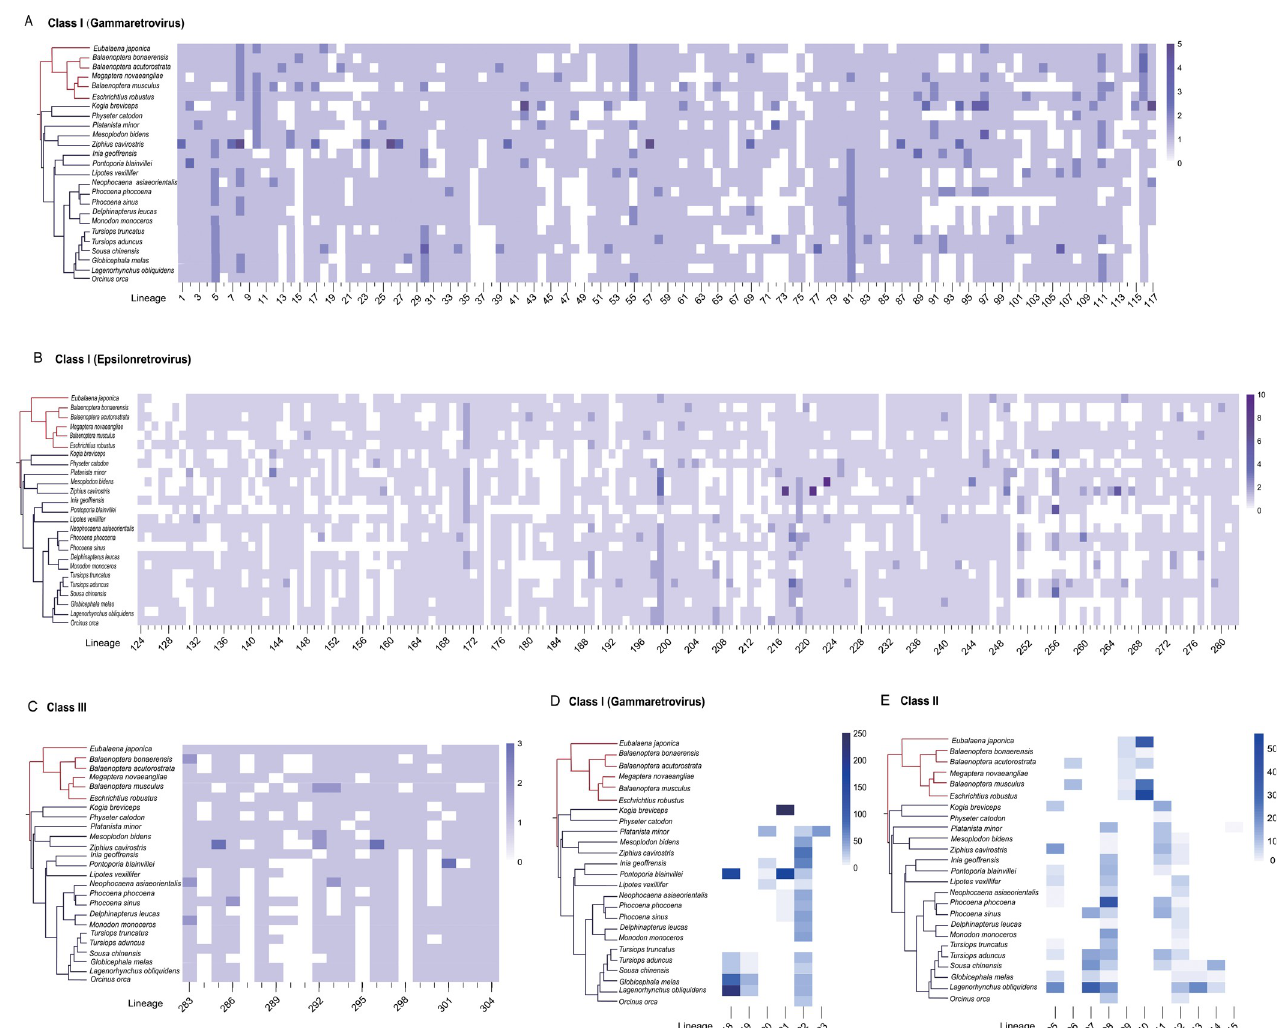
Fig 2. The copy numbers of distinct cetacean ERV lineages. ( A ), ( B ), and ( C ) show the copy numbers of ERVs in the LTW lineages that belong to Class I ERVs (gammaretrovirus), Class I ERVs (epsilonretrovirus), and Class III ERVs, respectively. ( D ) and ( E ) show the copy numbers of ERVs in the SHS lineages that belong to Class I ERVs (gammaretrovirus) and Class II ERVs, respectively. Phylogenetic relationship of cetaceans is shown on the left. Odontocetes and mysticetes are highlighted in blue and red,